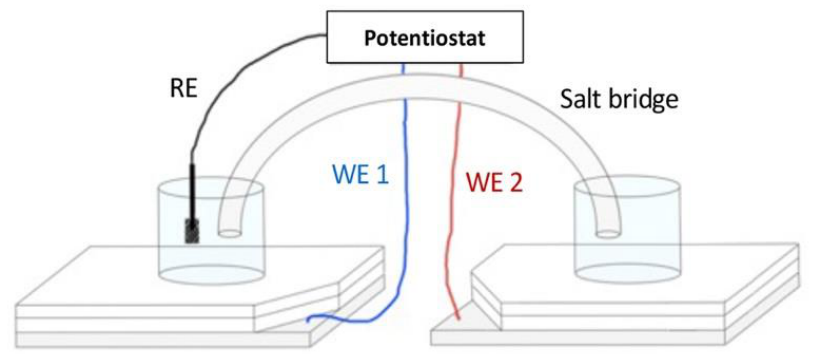
Figure 10. The traditional configuration for benchtop ENM measurement (personal drawing; inspiration from [92]).